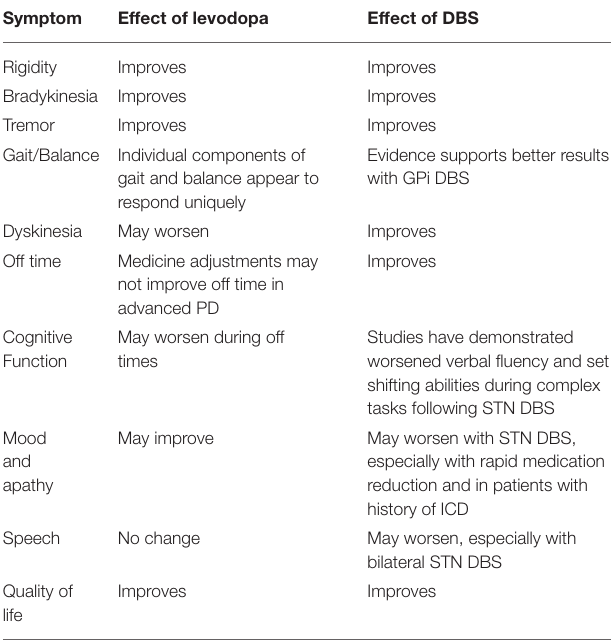
TABLE 1 | The Effect of Levodopa and DBS in Advanced